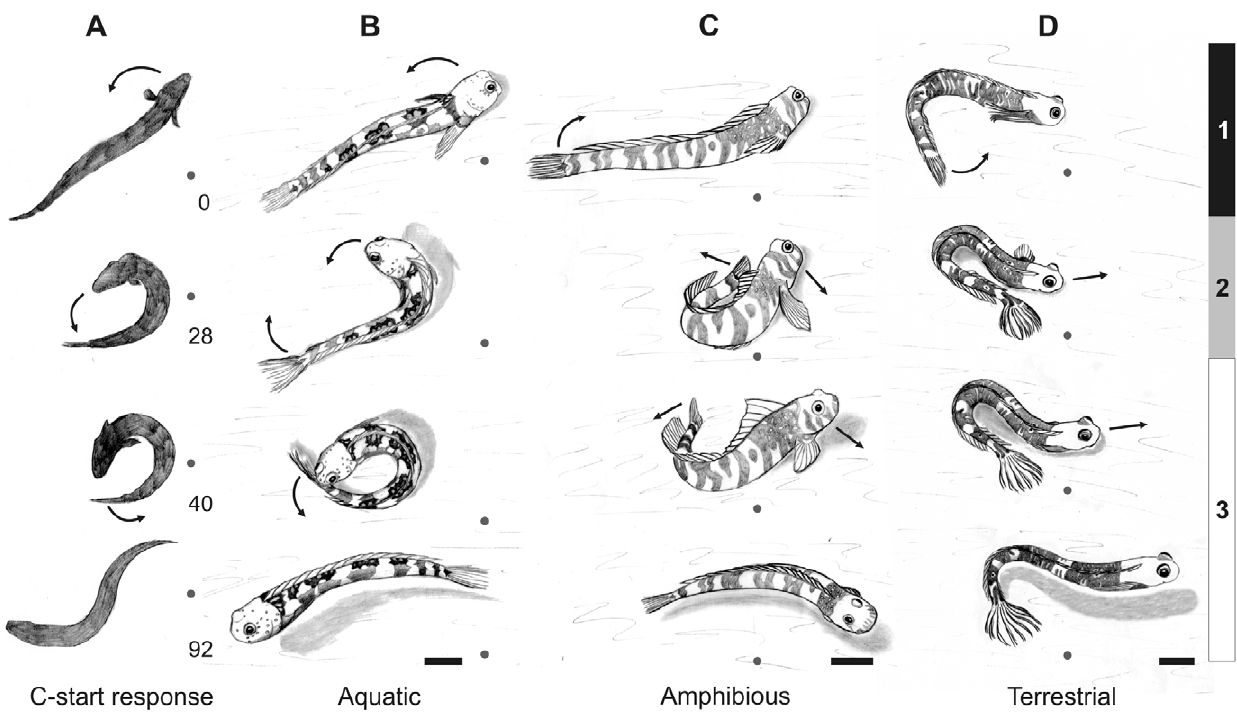
Figure 3. Comparison of aquatic escape and terrestrial jump maneuvers in aquatic, amphibious, and terrestrial fishes. a , An aquatic C-start escape response by a fully-aquatic fish, Polypterus senegalensis , modified from Tytell and Lauder [43]. b , An aquatic blenny ( Blenniella gibbifrons ) jumping on land. Note the lack of tail twisting and similar body position to the fish in panel a . c , An amphibious blenny ( Praealticus labrovittatus ) showing the stereotyped tail to head movement used for terrestrial locomotion. d , A terrestrial blenny, Alticus arnoldorum , demonstrating axial tail twisting. The numbered vertical bars to the right of panel d correspond to jump phases 1, 2, and 3, as shown in panels c and d . See text for descriptions of the phase kinematics. Blennies shown in panels b–d jumped off the same balsa wood surface. The terrestrial blenny never slipped, whereas all others did. Sketches were produced for greater visible clarity, and were traced from high-speed video frames. The gray circle serves as a fixed point. Five mm scale bars are provided at the bottom of panels b–d ; panel a serves as a generic kinematic reference for a C-